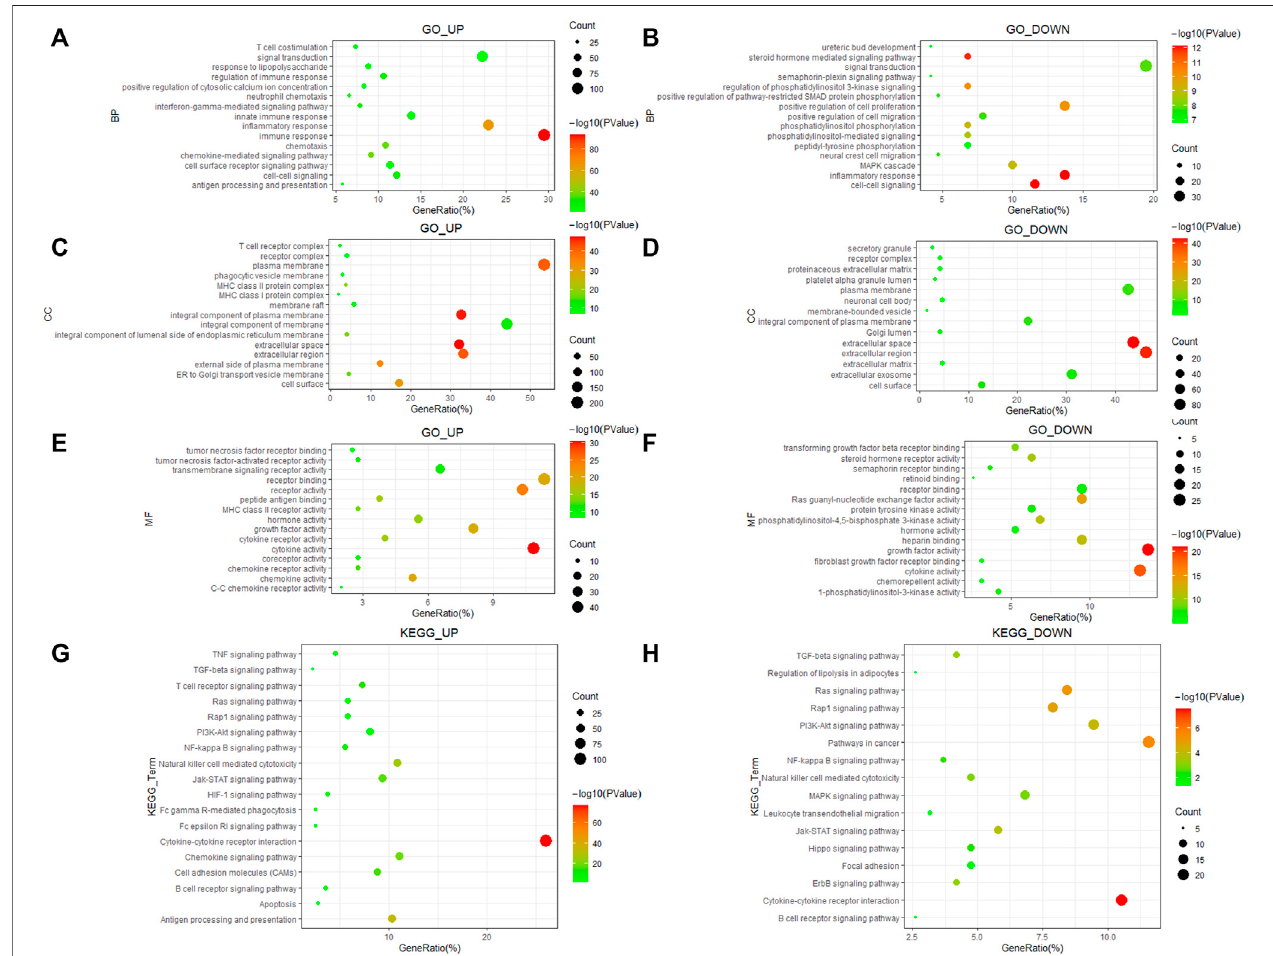
FIGURE 2 | GO and KEGG enrichment of 586 immune-related DEGs. (A,B) Biological process of DEGs. (C,D) Cellular component of DEGs. (E,F) Molecular function of DEGs. (G,H) KEGG pathways enrichment results of DEGs.